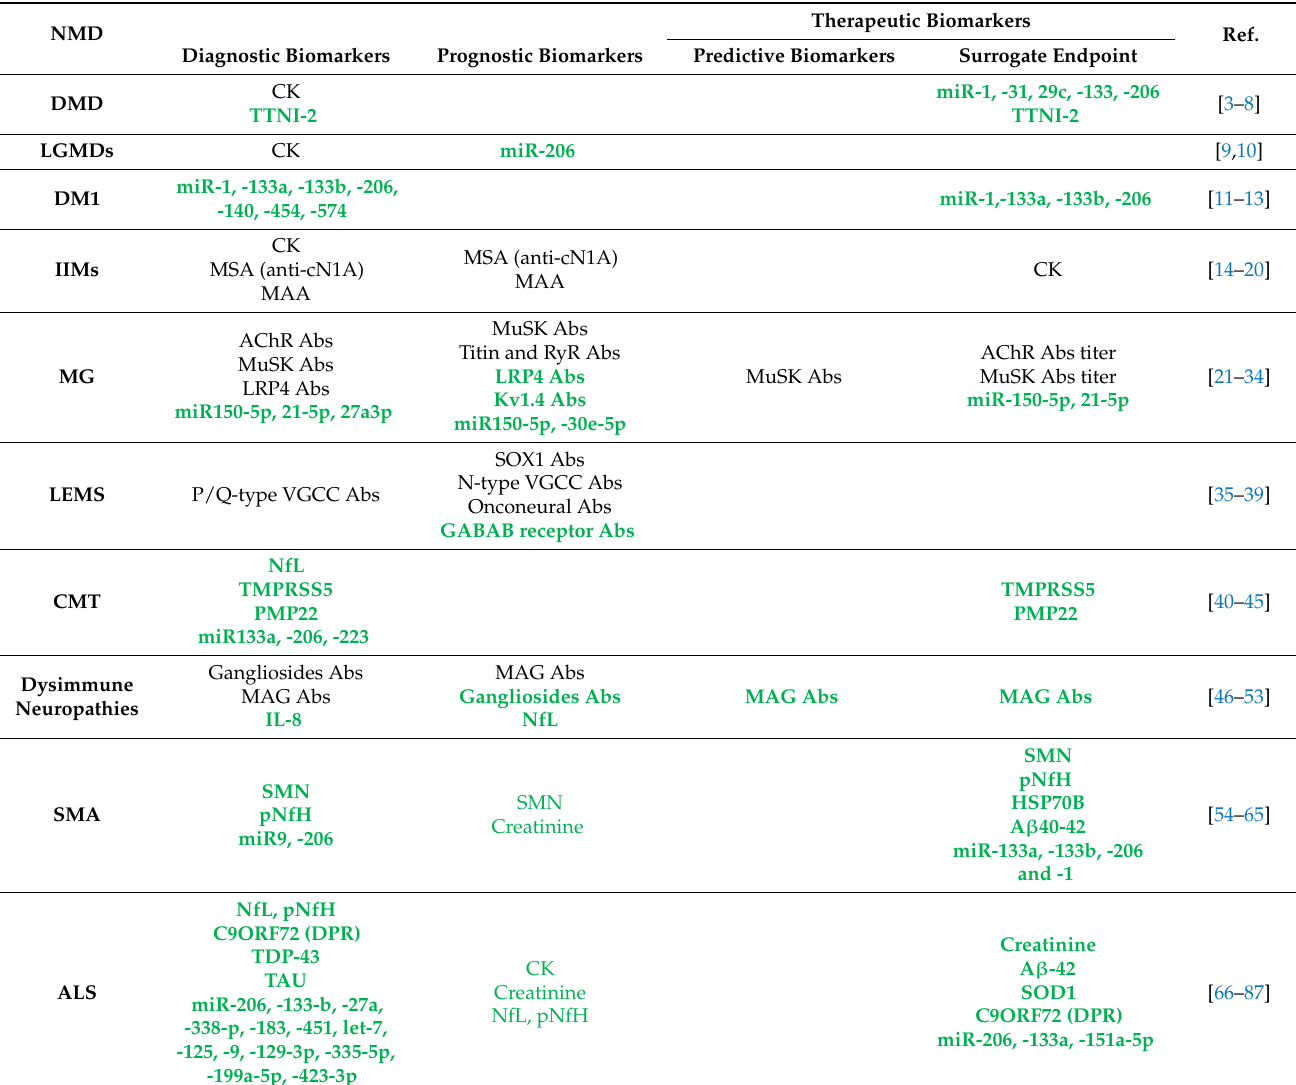
Table 1. Validated (in black) and emerging ( in green ) biomarkers in the most common neuromuscular disorders classified by clinical